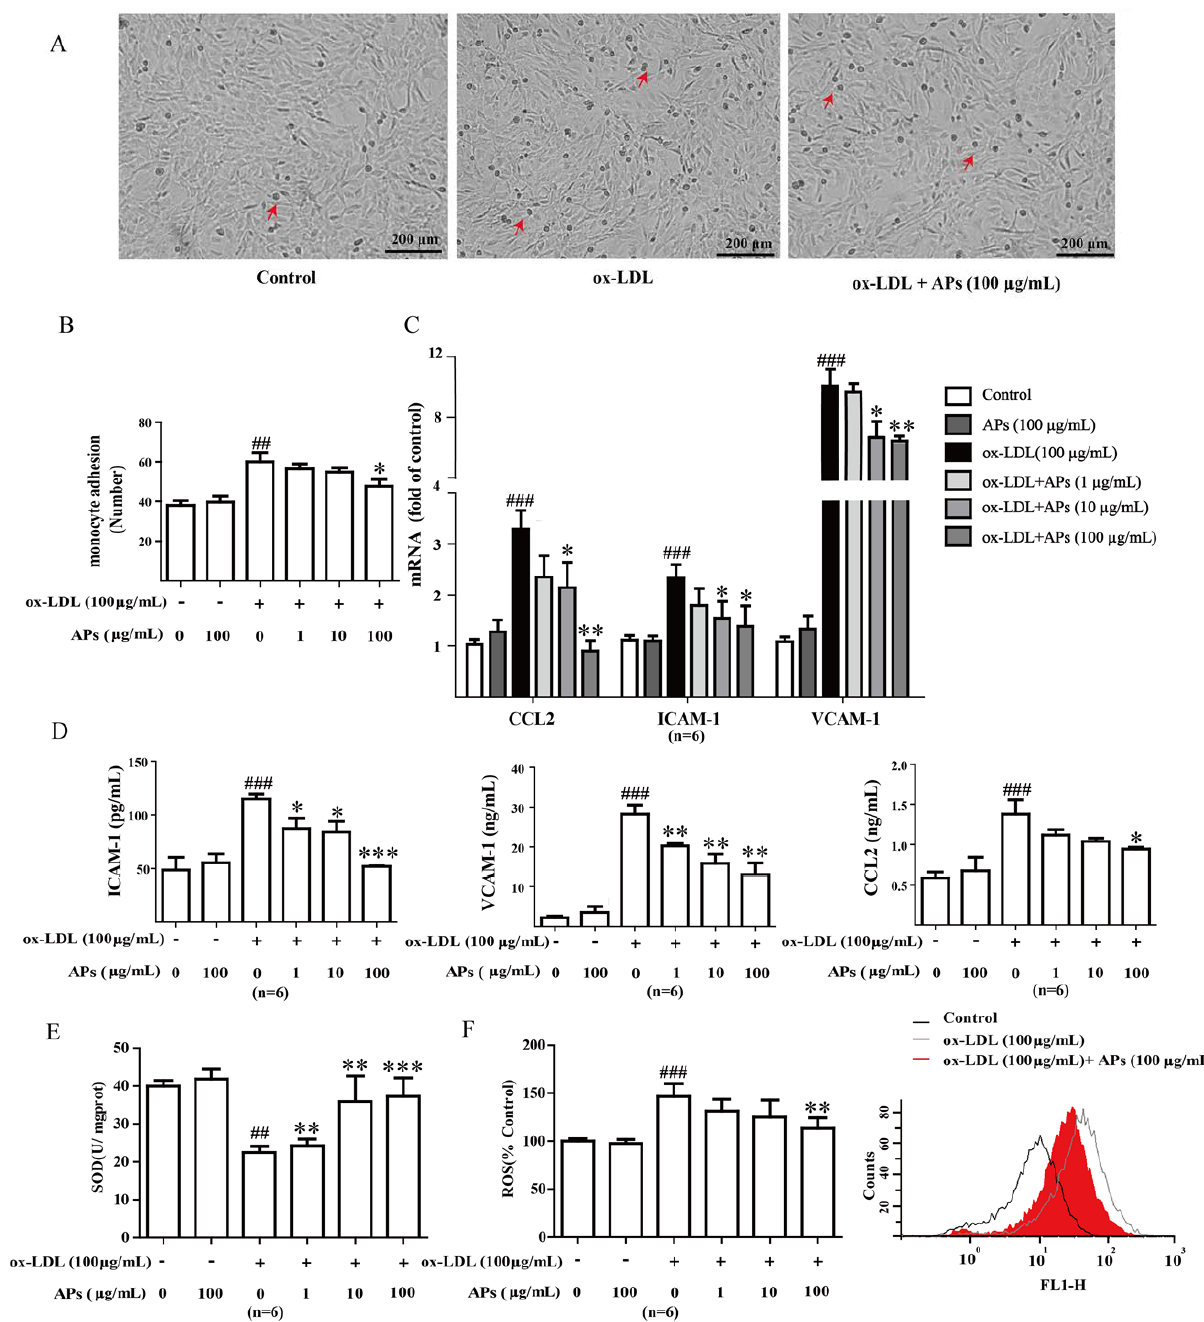
Figure 6. APs attenuate adhesion, decrease inflammatory factors and ameliorate oxidant stress in RAECs. A : Representative images of ox-LDL-induced monocyte adhesion to RAECs; B : APs treatment inhibits the ox-LDL-induced monocyte adhesion to RAECs in a concentration-dependent manner; C : CCL2, ICAM-1, and VCAM-1 gene expression in RAECs; D : CCL2, ICAM-1, and VCAM-1 level in RAECs supernatant; E : Activity of SOD in RAECs; F : Representative FACS plot of intracellular reactive oxygen species (ROS) and production in RAECs. The values are presented as the means ± S.E.M, n = 6 per group. # p < 0.05, ## p < 0.01, ### p < 0.001 vs. control group (0 µ g/mL). * p < 0.05, ** p < 0.01, *** p < 0.001 vs. ox-LDL alone.